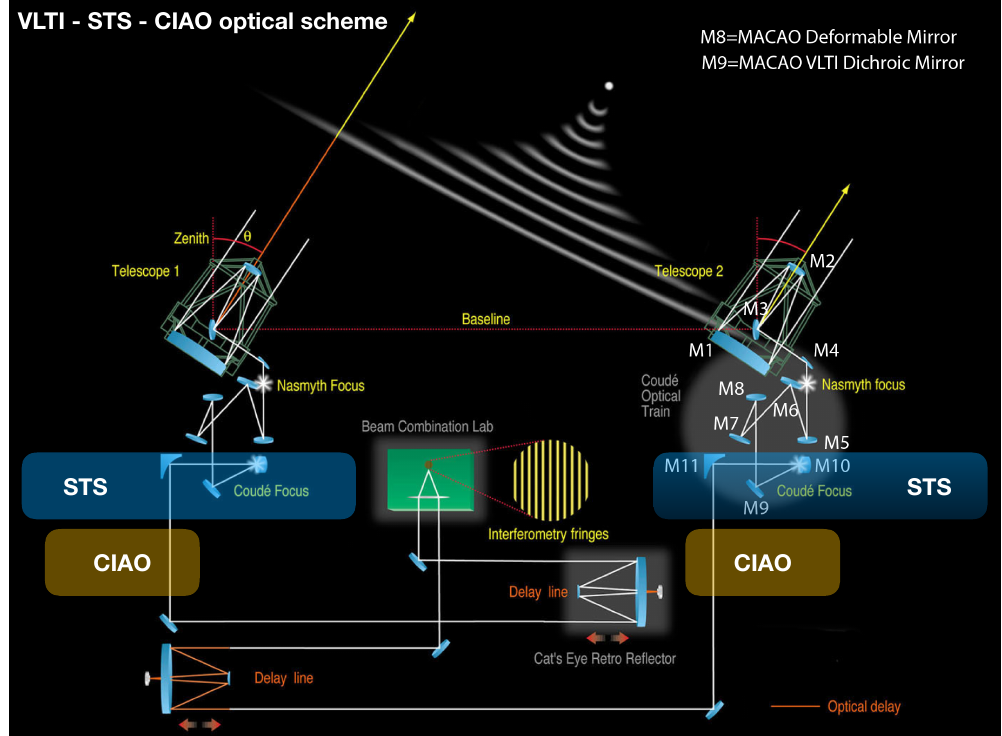
Figure 1. Schematics of the Very Large Telescope (VLT) interferometer optical path with 2 Unit Telescopes (UTs). The CIAO units are located in the Coudé focal station of the respective telescope. Light from a celestial object is reflected by 9 mirrors (Telescope 2: M1–M9) and is in focus at the mirror M10, located in the Coudé focal station. Star separator units (STS) units select 2 celestial objects within a field of view of 2arcmin diameter. The light of one object is relayed to CIAO, the light of the second object is relayed to the GRAVITY beam combiner, located in the beam combination lab. Delay lines compensate for optical path length differences between telescopes 1 and 2, which have a distance corresponding to the baseline. Mirror M8 is the deformable mirror shared between MACAO and CIAO. Mirror M9 is a dichroic beam-splitter that reflects infrared light to CIAO and the beam combination lab, visible light is transmitted to MACAO (not shown). Background image: European Southern Observatory